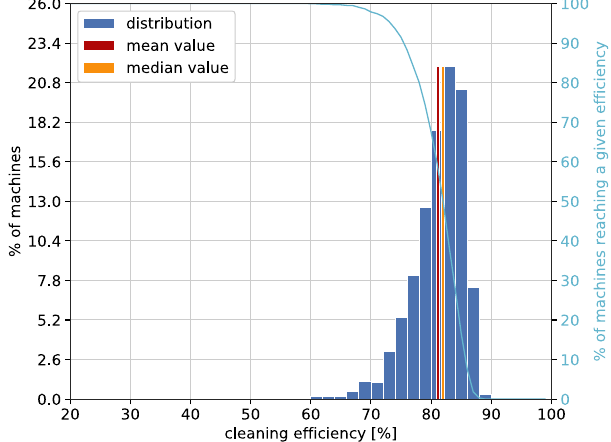
FIG. 14. Global cleaning efficiency distribution for about 2000 random machines with combined orbit and optics